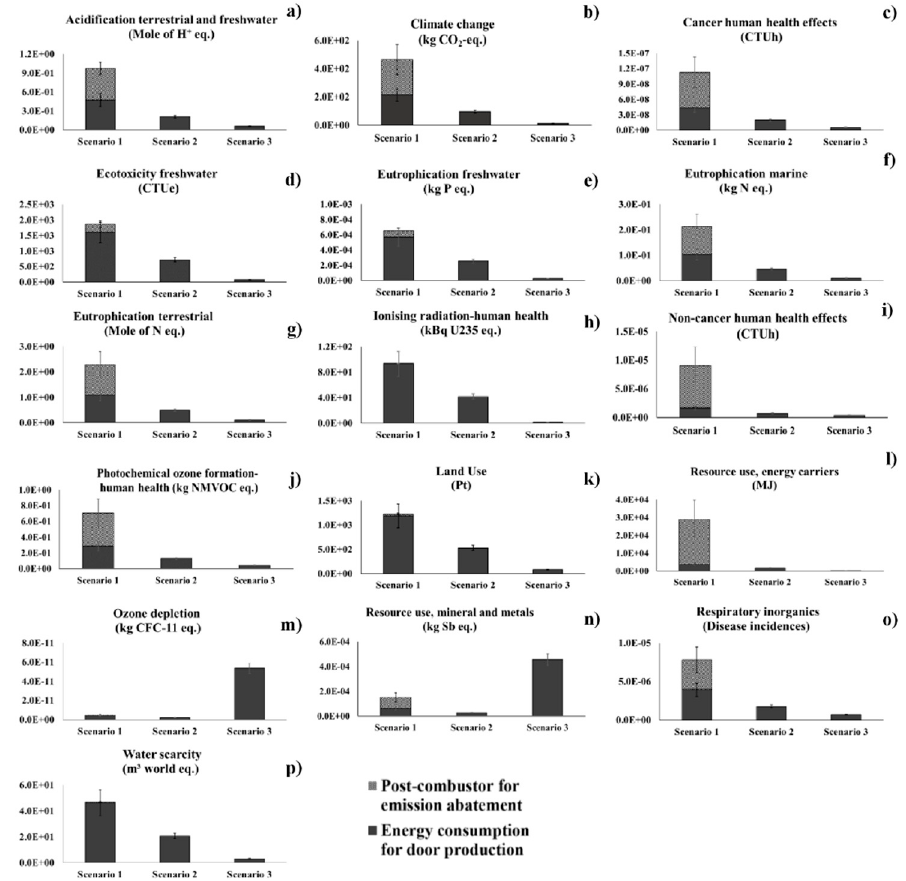
Figure 3. Results of LCA: classification and characterization steps (Scenario 1: current scenario; Scenario 2: innovative scenario; Scenario 3: innovative scenario combined with renewable energy use). Functional unit: 10 tons of wood products. Each letter ( a – p ) represents an impact category discussed in the manuscript. Appl. Sci. 2020 , 10 , x FOR PEER REVIEW